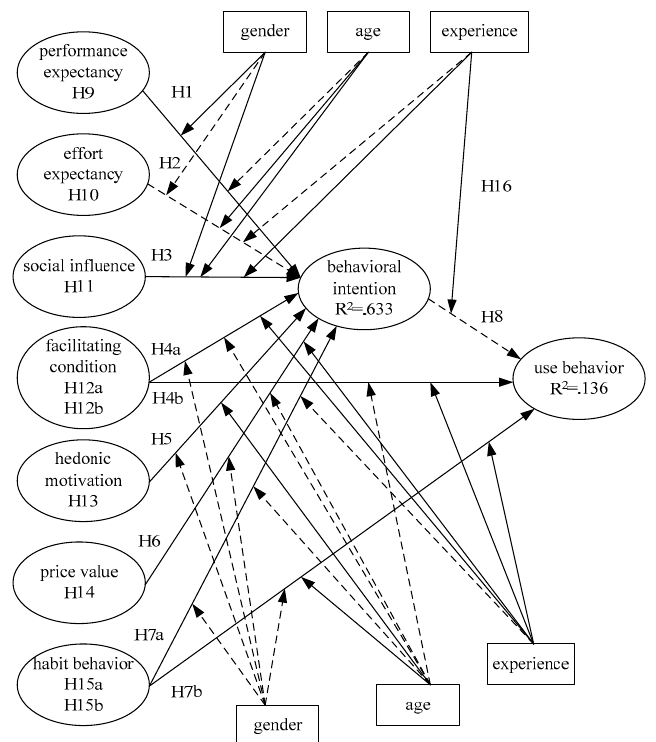
Figure 2. Structural equation modelling (SEM) results of the standardized model parameter estimation. (note: ”--“: path coefficient was not significant; ”-”: path coefficient was significant).